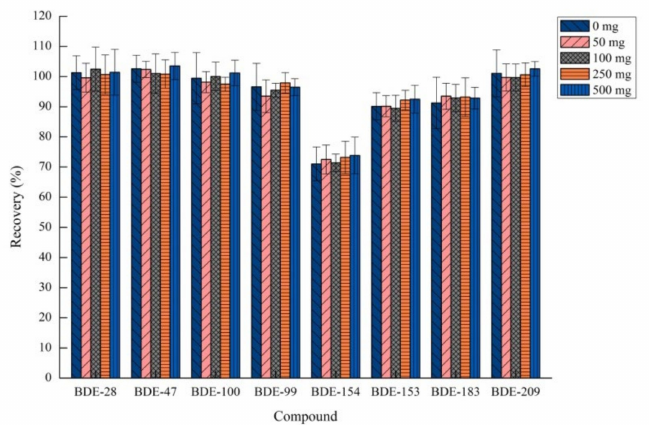
Figure 5. Effect of amount of sodium chloride on recovery ( n =